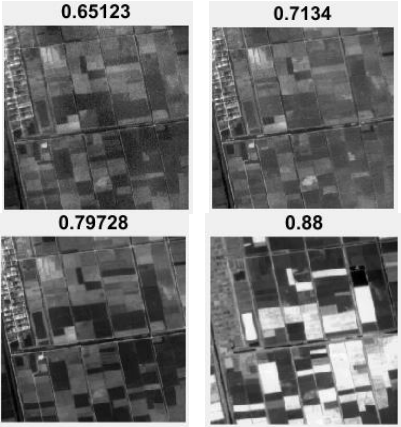
Figure 2. Four bands of an image patch with their subjective scores on title. Upper-left blue band, upper-right green band, lower-left red band and lower-right infrared. Notice that the infrared band has the highest quality score due to its less sensitivity to